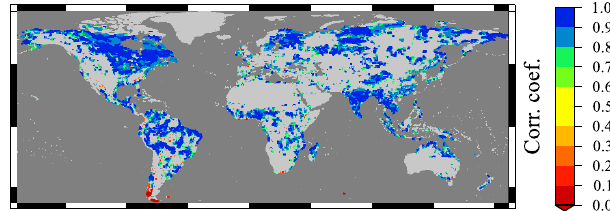
Fig. 10. Correlation coefficient of the temporal correlation between SIND and MPI-HM wetland extent climatologies. Only correlation with a significance higher than 90% are shown.